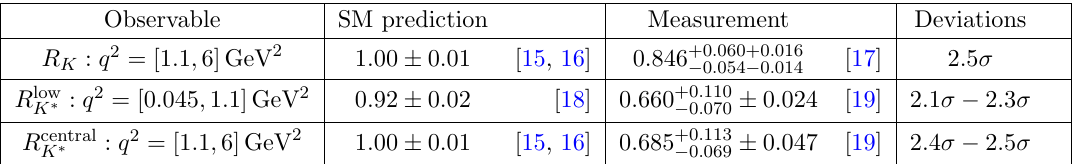
Table 1 . The experimental values of the observables along with their SM predictions for di(cid:11)erent ranges of q 2